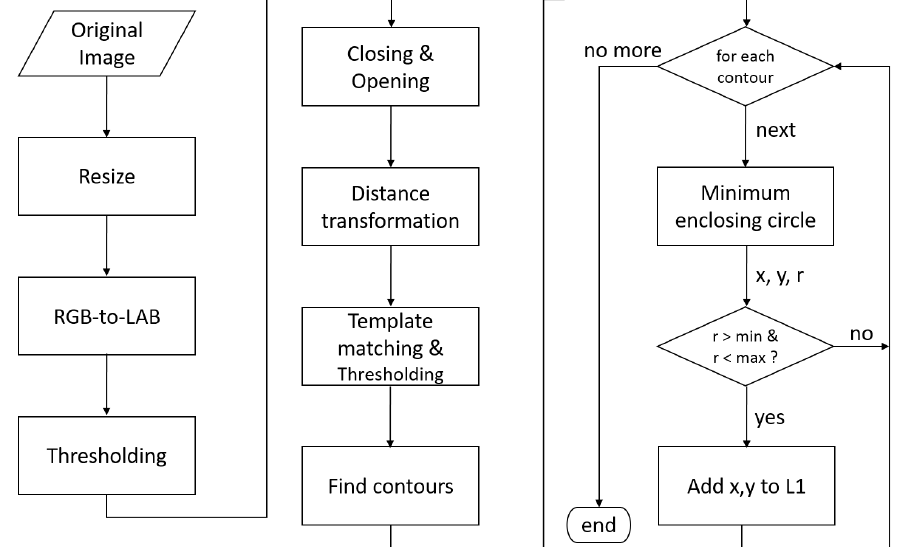
Figure 4. Flowchart of the color-based segmentation algorithm (x, y, and r are are the center pixel coordinates and the radius of the circle enclosing the detected trees; L1 is the output list with the image pixel coordinates of the detected